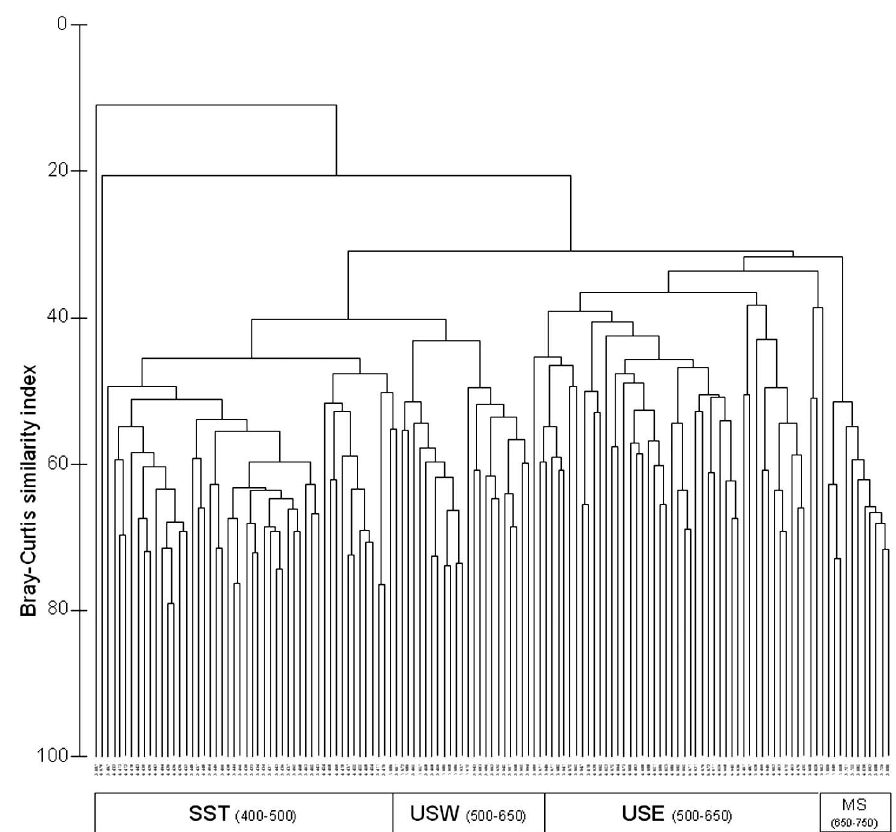
Fig . 2. – Dendrogram showing the clustering of hauls from the fish and invertebrate species matrix